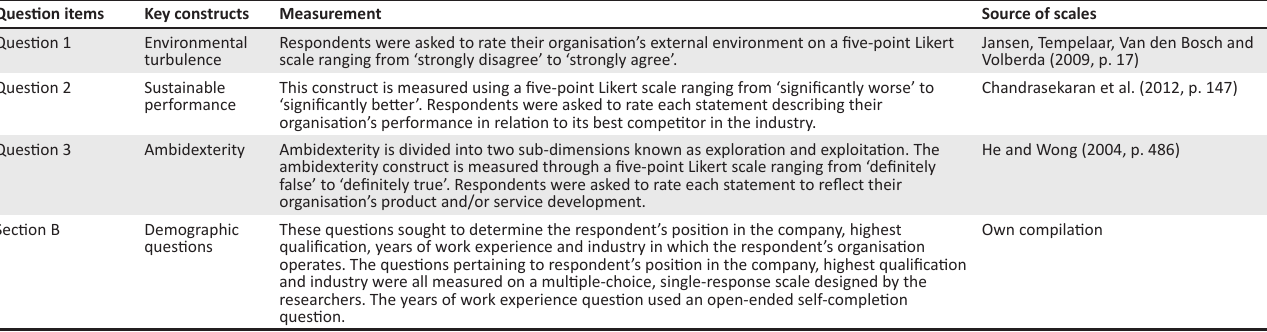
TABLE 1-A2: Questionnaire